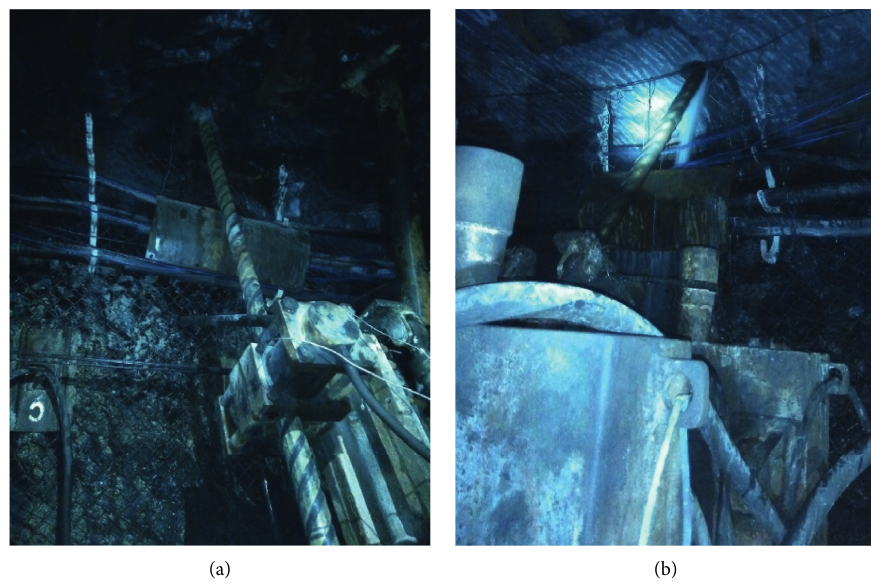
Figure 21: Field construction. (a) Drilling stage. (b) Slotting